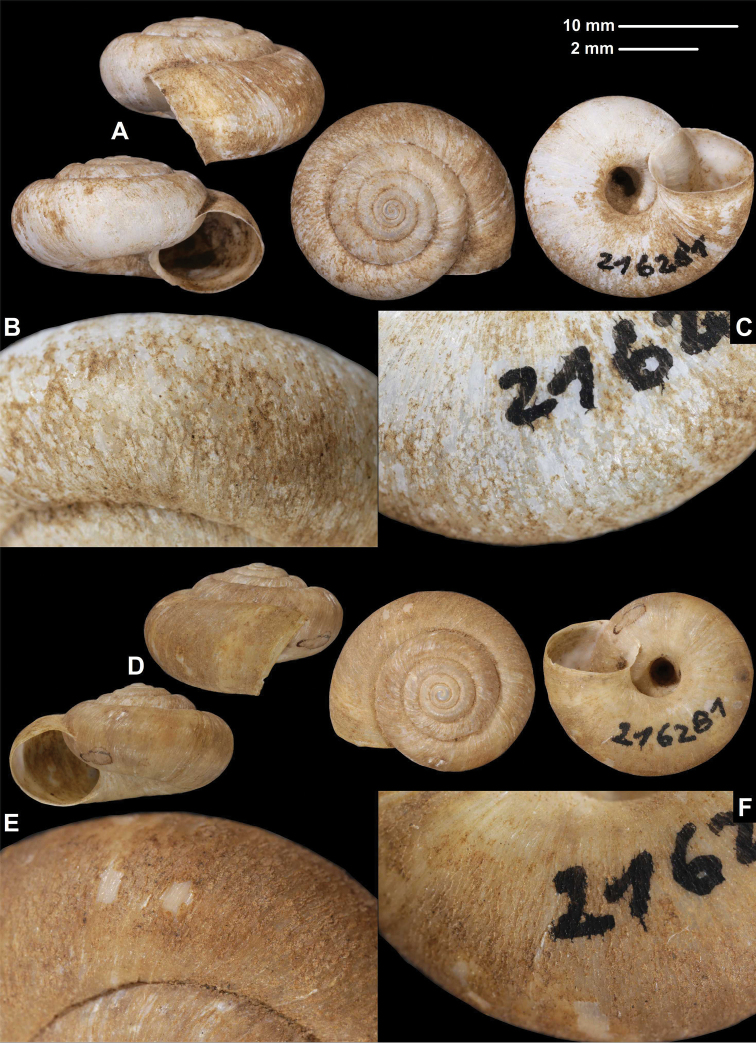
Shells (A, D), dorsal (B, E), and ventral (C, F) sculpture of Trichocathaicamacrosquamata Páll-Gergely sp. n. A–CSMF 349504 (paratype, D = 21.8 mm) D–FSMF 216281 (holotype, D = 18.8 mm). Scale bars: Upper scale (A, D), lower scale (B, C, E, F). All photos: B. Páll-Gergely.